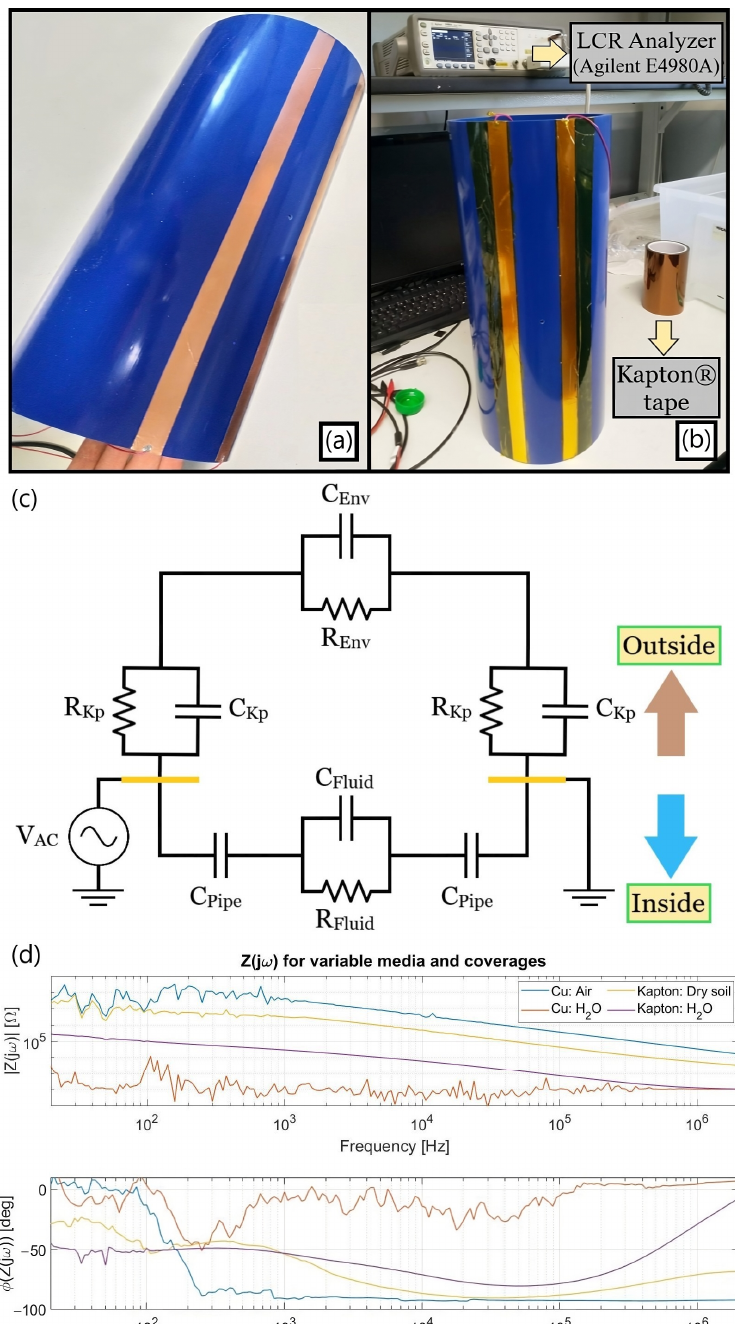
Figure 6. ( a ) Exposed copper strips with the heuristically optimal dimensions (G, W) = (50, 20) [mm, mm]; ( b ) Kapton ® -covered electrodes and the LCR instrument capable of measuring up to 2 MHz; ( c ) First improved electrical equivalent model, further revisited after some adjustments in the empirical setup; ( d ) Initial impedance spectra set gauged with the LCR instrument when air filled the pipe.